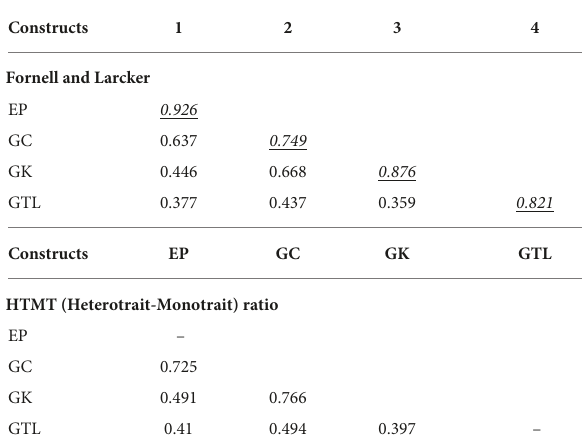
TABLE 4 Discriminant validity. TABLE 5 Model fit and predictive relevance.